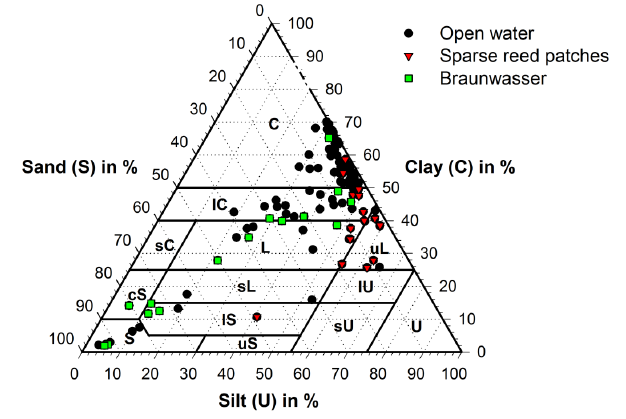
Figure 4. Soil texture triangle (after ÖNORM L 1050) including all ecotope-specific sediment samples. It highlights a highly clay- dominated environment, especially at the open water. A trend to clay content below 50% is evident for the water patches within the reed.